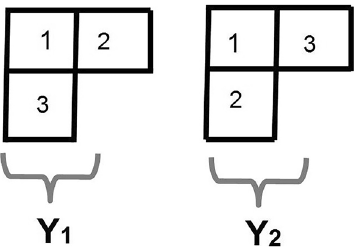
Figure 1. The standard Young Tableau generating the 2D IR of S 3